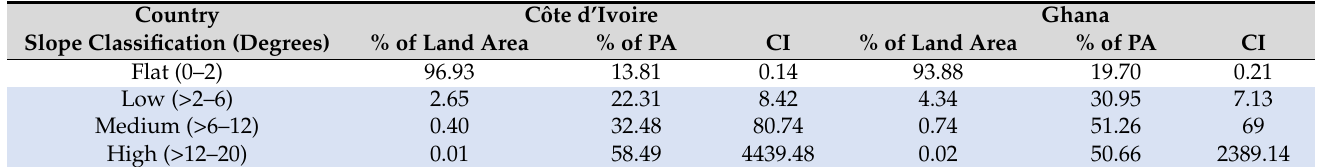
Table 5. The comparison index (CI) for all protected areas (IUCN PA categories, those without assigned categorizations (not reported) and World Heritage Sites or UNESCO MAB reserves (not applicable)) and their percentage land areas of slope classes in Ghana and C ô te d’Ivoire. Blue highlighting indicates good representation (CI > 1).